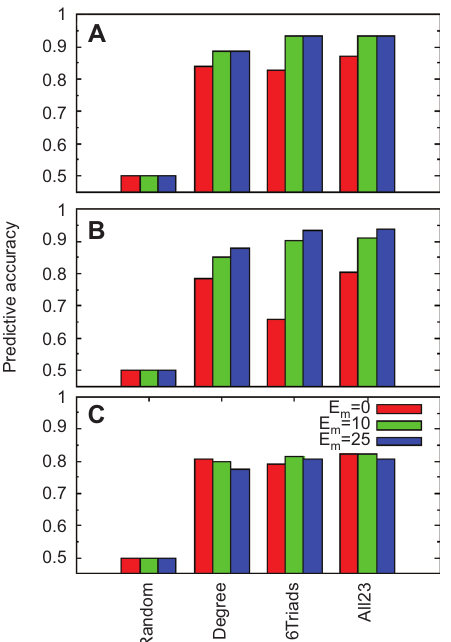
Figure 1. Accuracy of Predicting a Sign of Edge in Network. (A) Epinions, (B) Slashdot, (C)